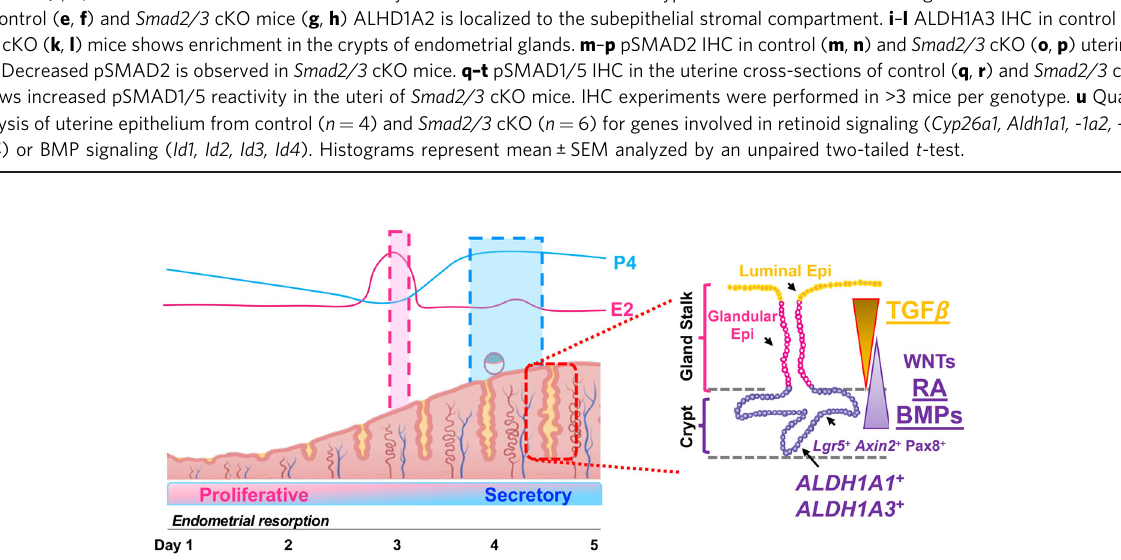
Fig. 8 Schematic showing the effect of TGF β signaling in endometrial cell regeneration and differentiation. Diagram indicating the dynamic remodeling of the endometrium throughout the estrous cycle, transitioning from a proliferative to a secretory state under the control of the steroid hormones, estrogen (E2) and progesterone (P4). The regenerative potential of the endometrium is controlled by the presence of endometrial Lgr5 + , Axin2 + , and Pax8 + stem cells, likely in the crypts of the uterine glands, with growth factors such as WNTs, controlling differentiation. Our results indicate that Aldh1a1 + and Aldh1a3 + cells are putative endometrial stem cells in the uterine glands that are controlled by TGF β , BMP and retinoic acid (RA)